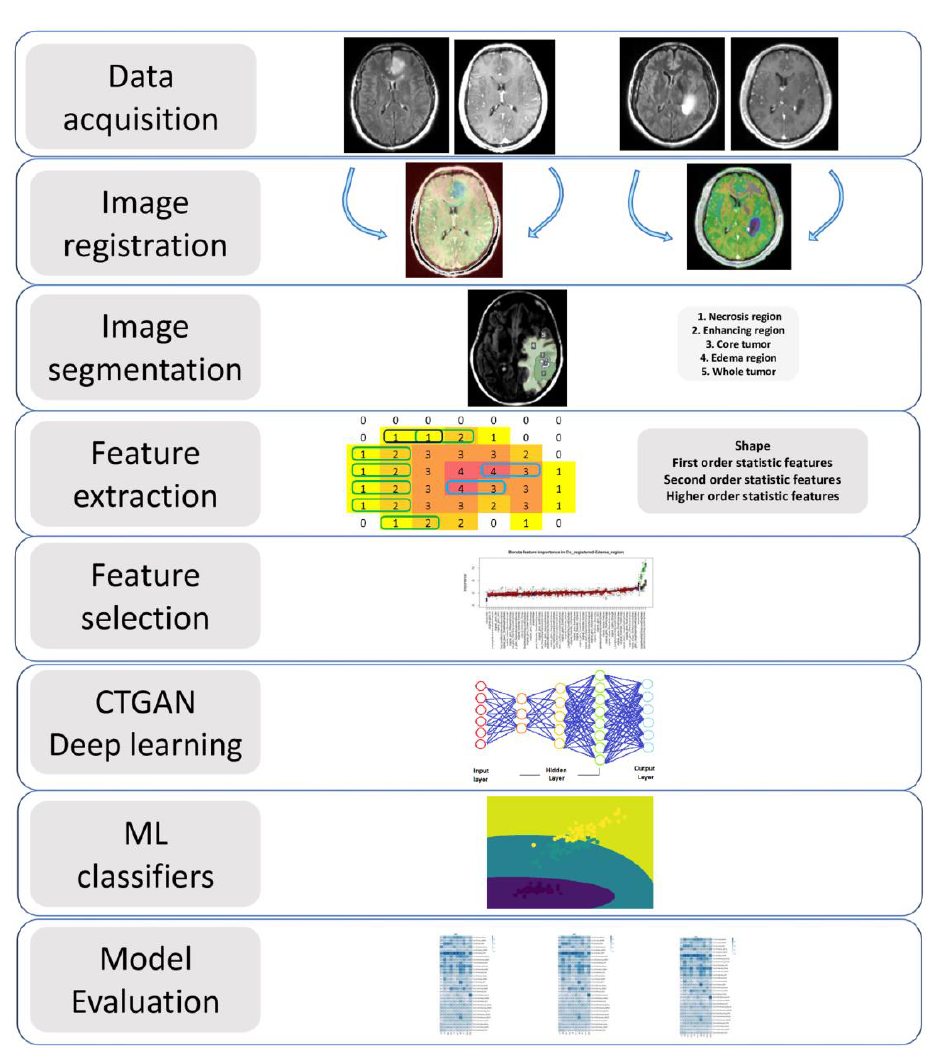
Figure 3. 2D and 3D visualization of various subregions of a grade 4 astrocytoma as visible on T2- FLAIR image. 2.5. Radiomic Feature Extraction From each segmented ROI, 105 original radiomic features from categories (shape, first-order statistical, second-order texture, and higher-order statistic) were extracted us- ing the PyRadiomics package in python [32]. These original features can be sub-divided into 7 classes, including 13 shape features, 18 first-order statistical features, 23 gray level co-occurrence matrix (GLCM) features, 14 gray level dependence matrix (GLDM) fea- tures, 16 gray level size zone matrix (GLSZM) features, 16 gray level run length matrix (GLRLM) features, and 5 neighboring gray-tone difference matrix (NGTDM) features.